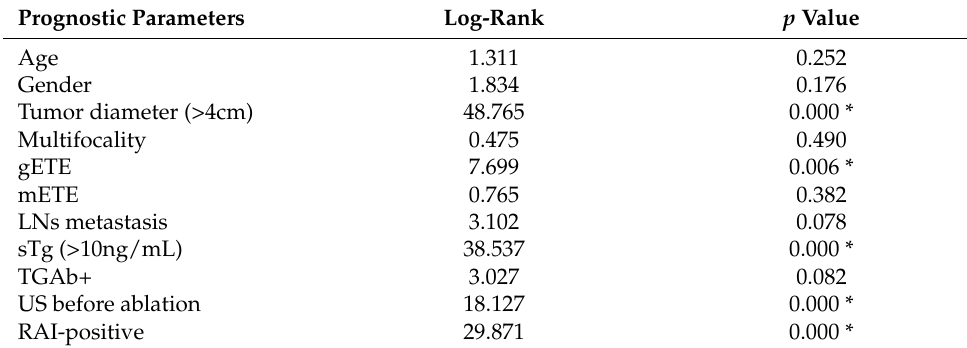
Table 3. Log-rank analysis of clinical